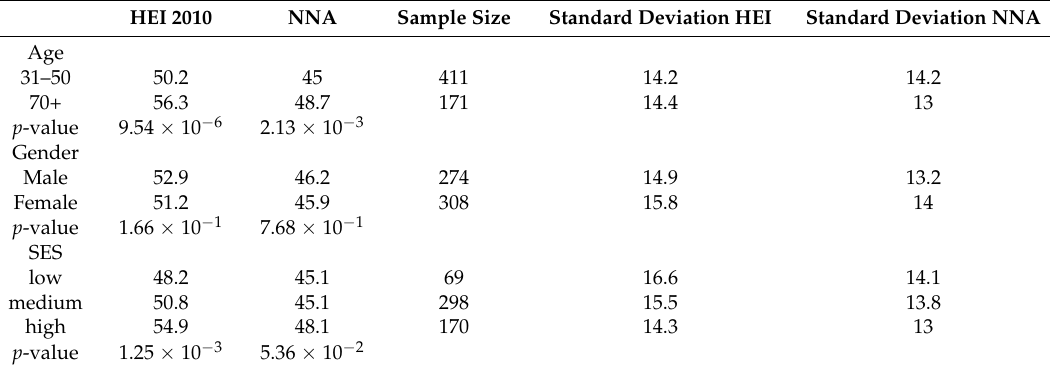
Table 3. Comparison between NNA and NHANES 2011–2012 (day 1) for age, gender, and socioeconomic status (SES), with energy intakes between 1700 and 2300 kcal.